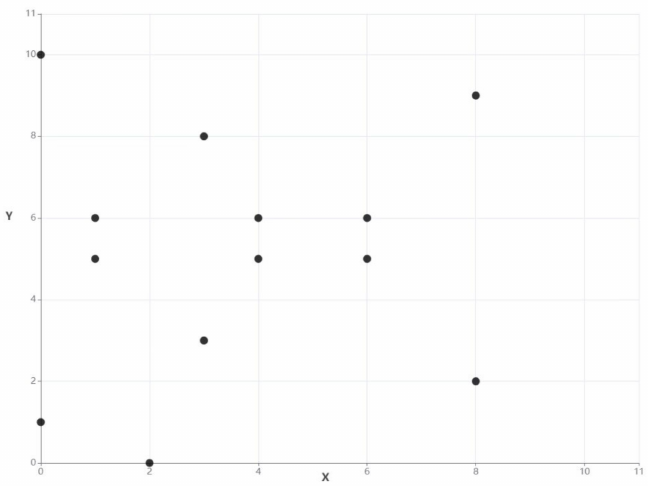
Figure 6. Scatter plot at p = 11.